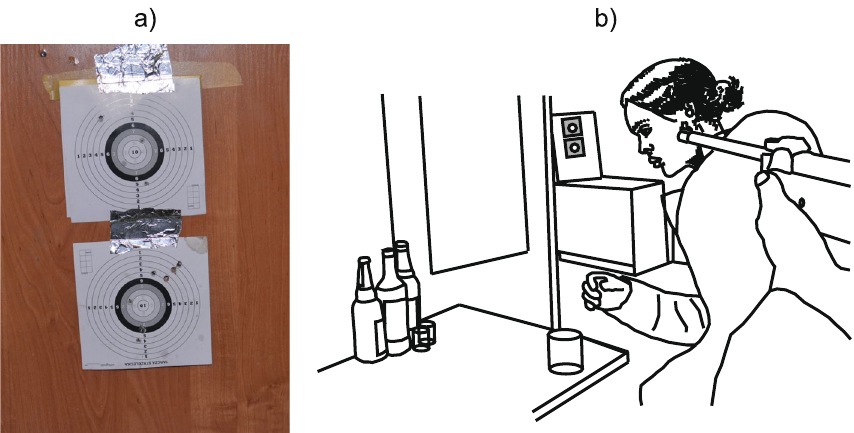
Fig. 2 Site of the incident and a reconstruction scheme: a targets used for aiming the airgun and b scheme of the incident and accidental shooting in the temporal region of the head in the victim reaching for a glass on the coffee